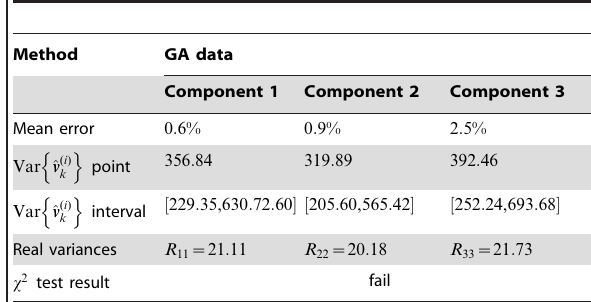
Table 7. x 2 test results for the estimation of 18 parameters in the repressilator model (genetic algorithm).